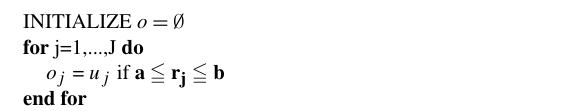
Algorithm 1 Subset an ungridded dataset given lower and upper bounds ( a and b respectively) and return the subset as o .